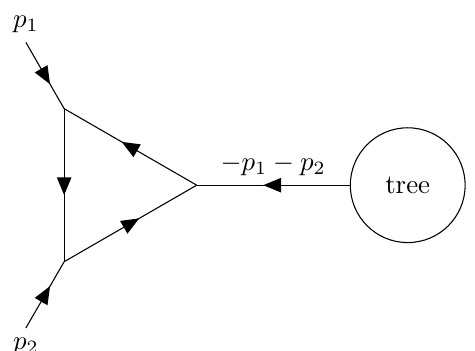
Figure 4 . This diagram is responsible for double poles in 1-loop amplitudes in the holomorphic collinear limit. Arrows indicate the flow of momenta and helicity through the